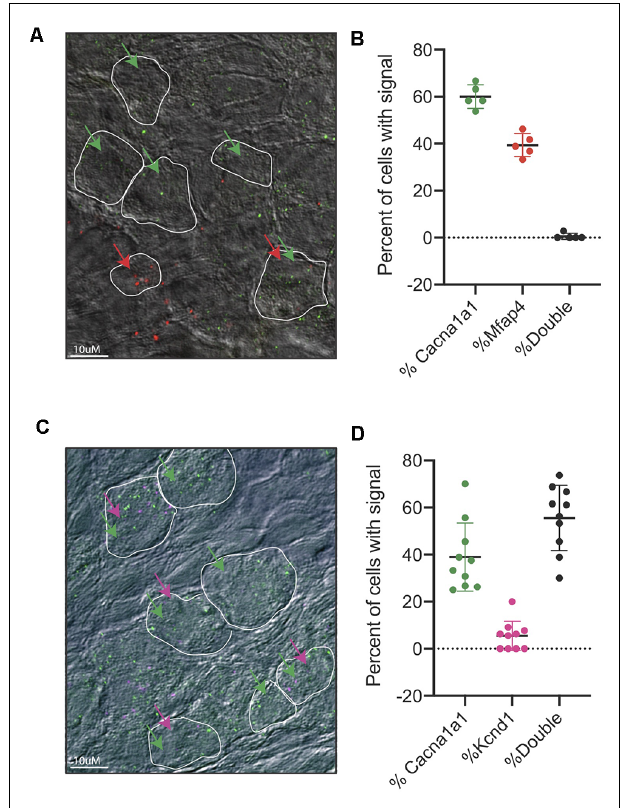
FIGURE 6 | RNA-scope of Cacna1a and Kcnd2 . (A) Representative image from RNAscope in situ hybridizations of Cacn1a1 (green) and Mfap4 (red) with bright field merge at postnatal day 8 from cryopreserved cochlear tissue. White boundaries indicate cells; green arrows indicate cells expressing Cacna1a , and red arrows indicate cells expressing Mfap4 . (B) Quantification of cells expressing either Cacna1 only (60% ± 5%) or Mfap4 only (39.4% ± 4.8%) or both (0.6% ± 1.25%) as percentage of all cells scored per image. Cells were considered positive if they had >1 dot per cell, 5 independent images ( n = 5 mice) were scored. Each point represents a scored image; all data presented as average ± STD. (C) Representative image from RNAscope in situ hybridizations of Cacn1a1 (green) and Kcnd2 (purple) with bright field merge at postnatal day 8. White boundaries indicate cells; green arrows indicate cells expressing Cacna1a , and purple arrows indicate cells expressing Kcnd2 . (D) Quantification of cells expressing either Cacna1 only (38% ± 14.5%) or Kcnd2 only (5% ± 6%) or both (55.9% ± 13.9%) as a percentage of all cells scored per image. Cells were considered positive if they had >1 dot per cell, 10 independent images ( n = 10 mice) were scored. Each point represents a scored image; all data presented as average ±